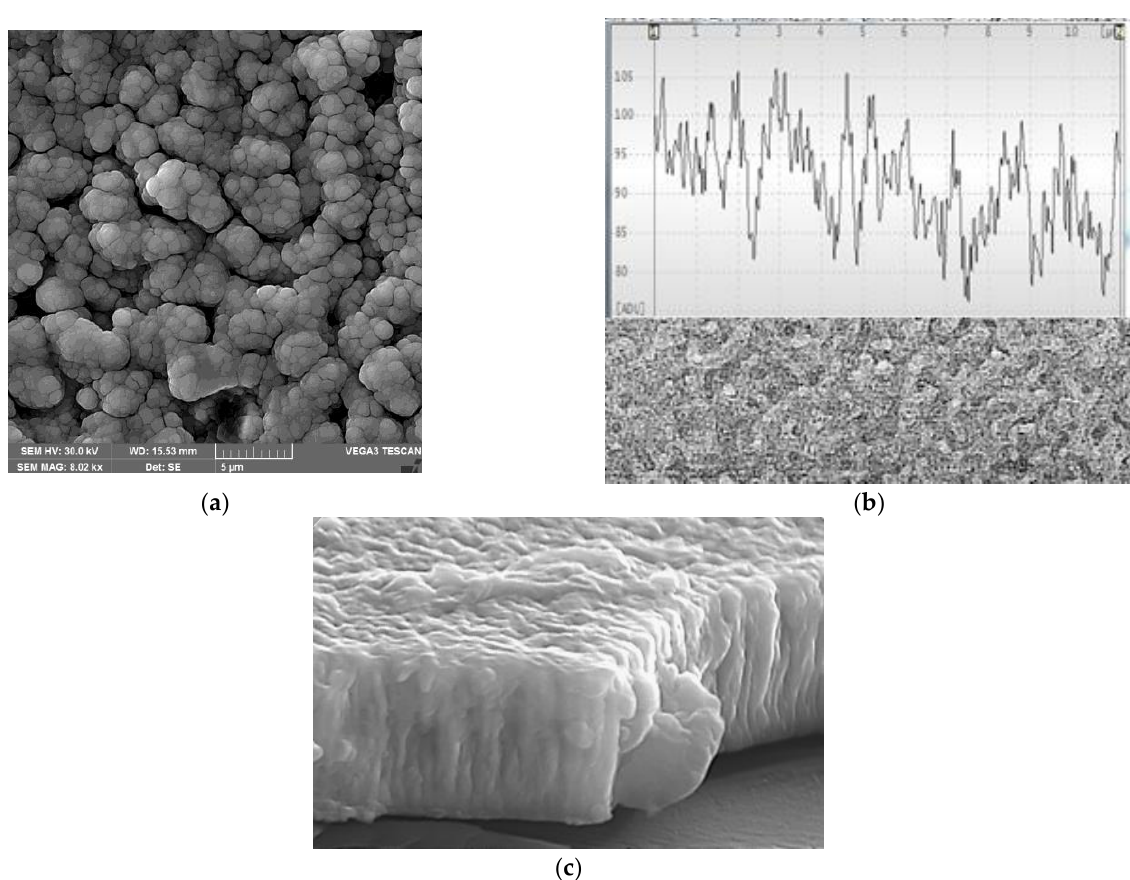
Figure 7. SEM images of the sputter-deposited Ti-Ni-Cu film: ( a ) surface image showing ultrafine microstructure; ( b ) surface topography analysis indicating micrometer and sub-micrometer grains; ( c ) cross-section image (8.600× magnification).